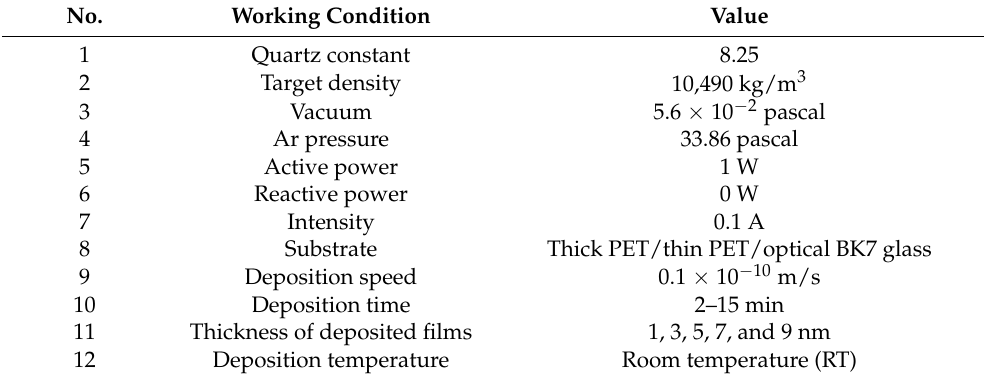
Table 1. Deposition conditions.